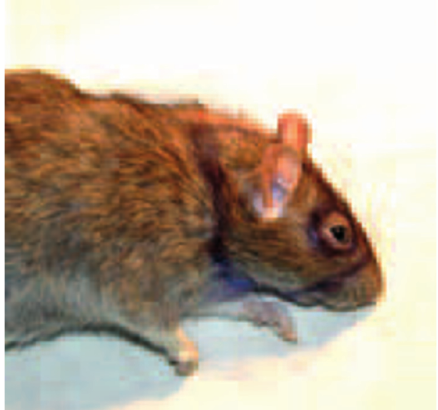
Figure 1. The donor rat Brown Norway